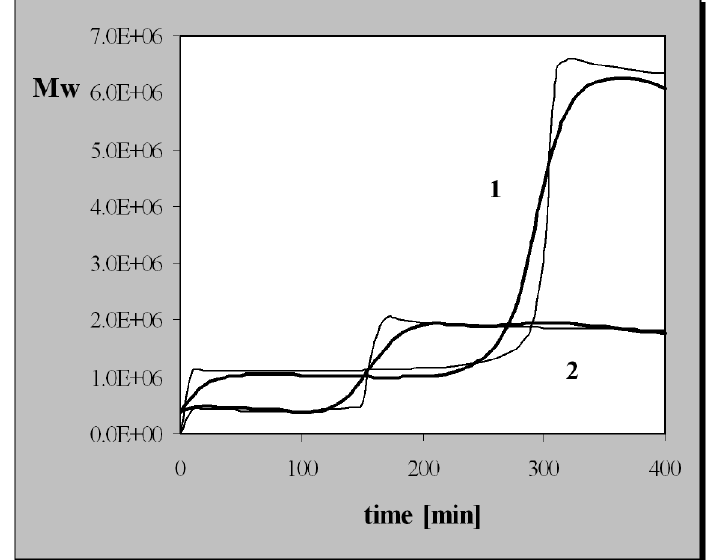
Fig. 18 Variation of weight average molecular weight with time for: (1) T = 50 o C and I 0 = 15.48 mol/m 3 ; (2) T = 50 o C and I 0 = 100 mol/m 3 ; thick lines - predictions on MLP (3:9:3:3), thin lines - kinetic model [18],